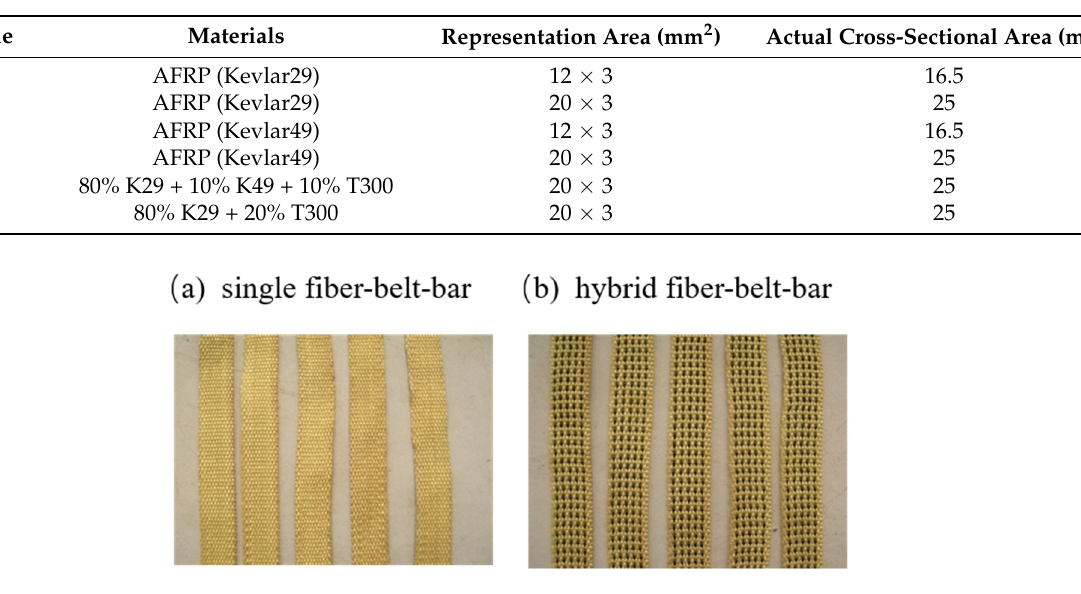
Table 1. Details of the fiber-belt-bar parameters.